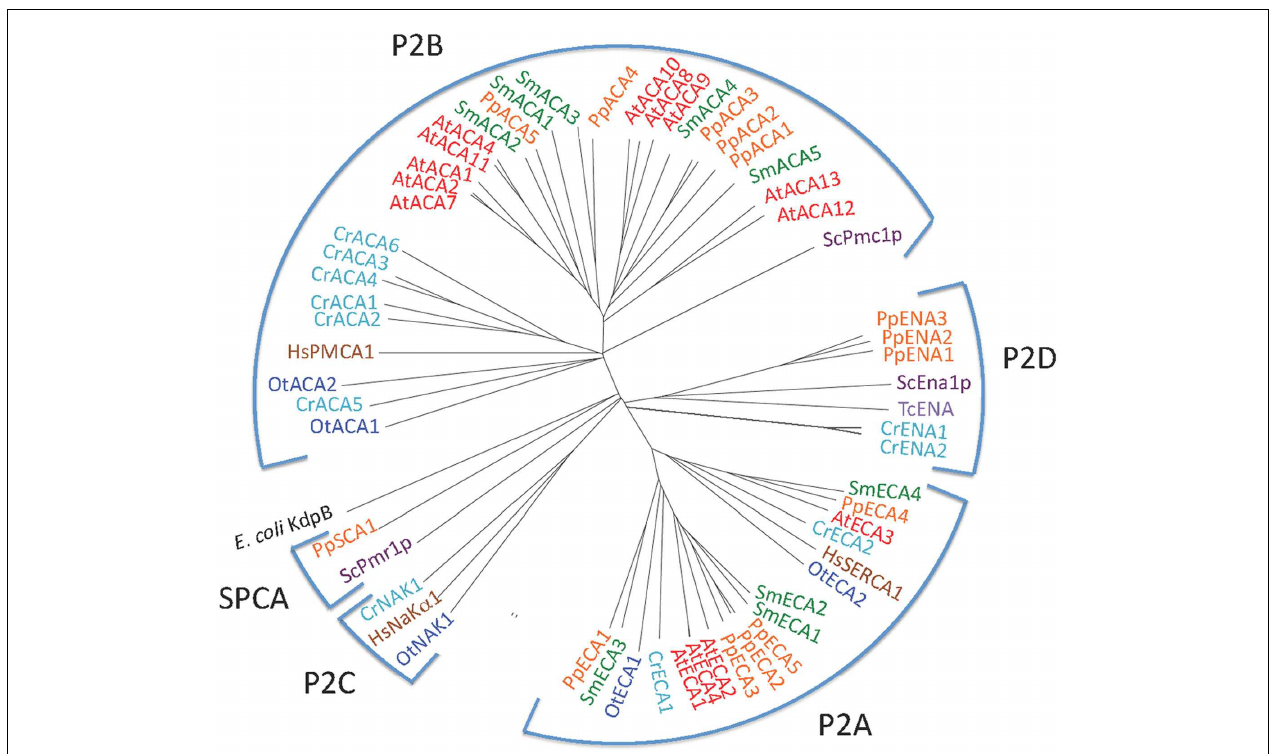
the S. cerevisiae pumps ScPmr1p (P13586), ScPmc1p (P38929), and ScEna1p (P13857), the H. sapiens pumps HsPMCA1 (P20200), HsSERCA1